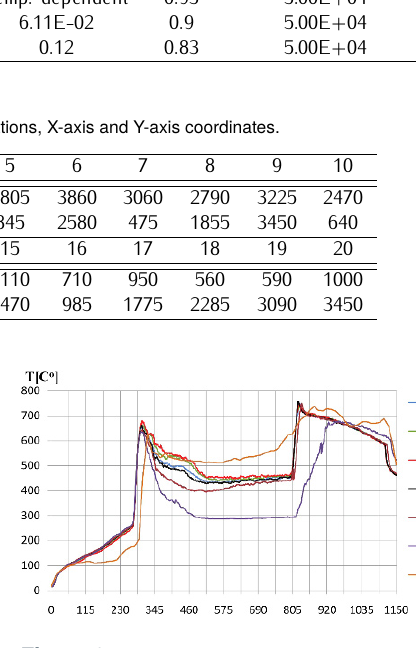
Figure 10 illustrates the visibility during the fire develop- ment. As it can be seen the visibility drastically decreases at 270 seconds and totally disappears at 300. The visibility occurs again after South pane breakage of Window 1 at 1111 seconds.